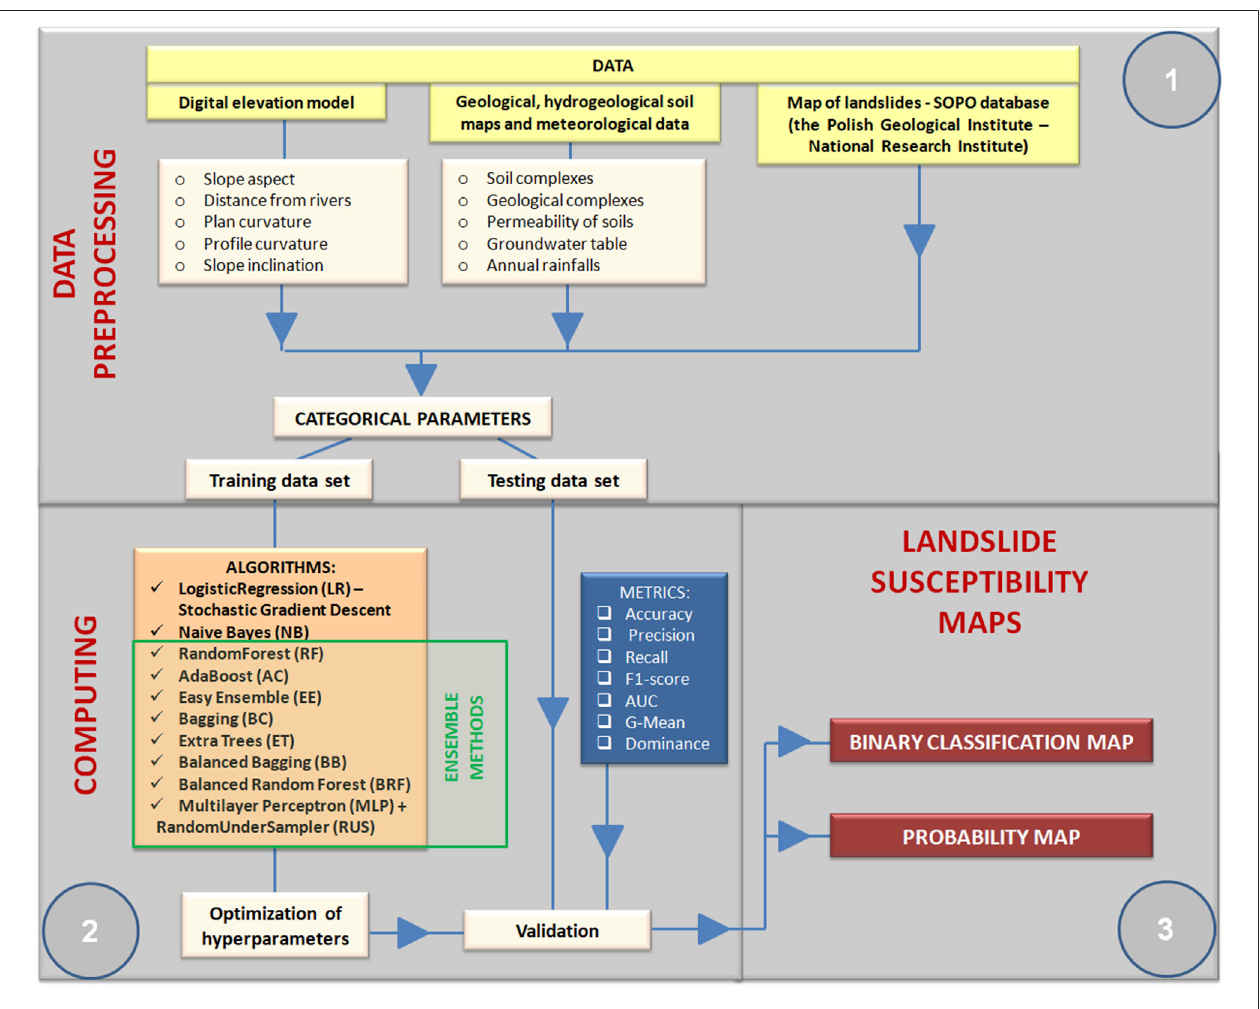
FIGURE 4 | Computational